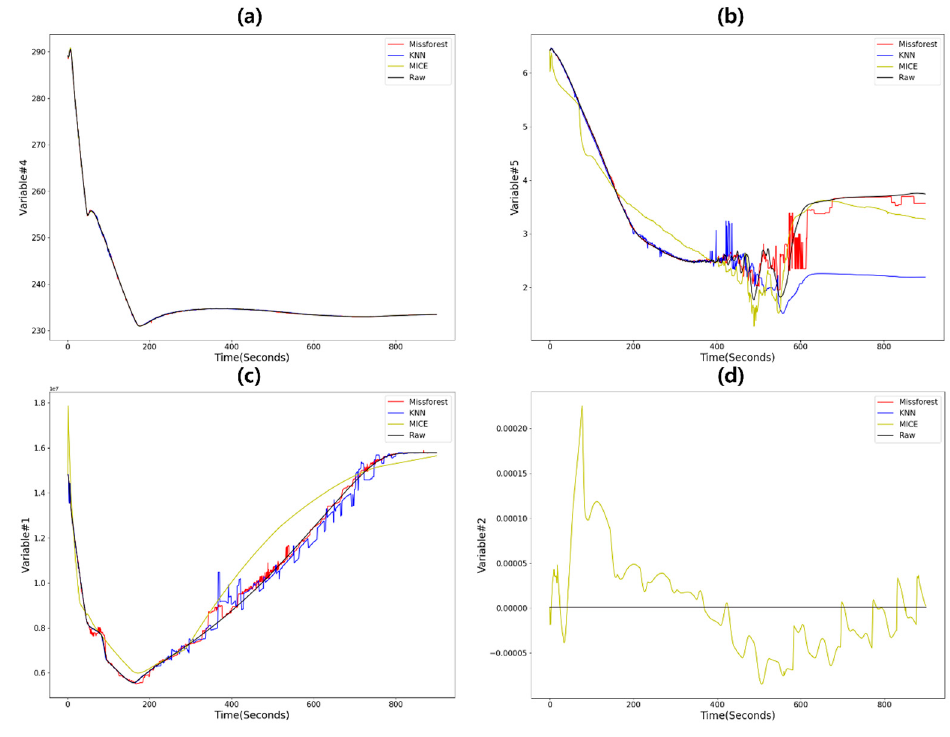
Figure 8. Comparison of imputation results showing ( a ) fine imputation by all models for variable #4 fault, ( b ) the maximum error of K-nearest neighbors (KNN) for variable #5 fault, ( c ) accurate performance of Missforest for variable #1 fault, and ( d ) the maximum error of multivariate imputation with chained equations (MICE) for variable #2 fault.